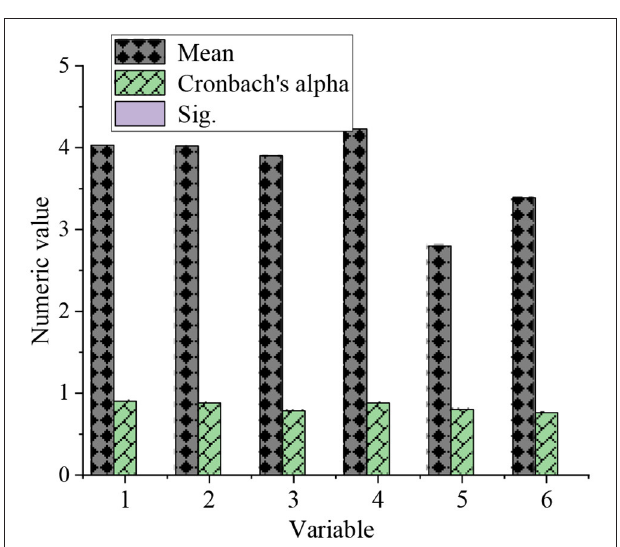
FIGURE 6 | Reliability test results of the